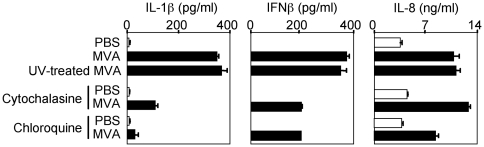
Endocytosis is required for IL-1β and IFNβ production after MVA infection.THP-1 cells were preincubated for 1 h with or without cytochalasin (2 µM) or chloroquine (100 µM) prior to exposure to MVA or UV-treated MVA (MOI 20). Cell-culture supernatants were harvested after 6 h (IL-1β) or 24 h (IFNβ and IL-8) and cytokine concentrations were measured by ELISA. Data are means±SD of triplicate samples from one experiment and are representative of two independent experiments.